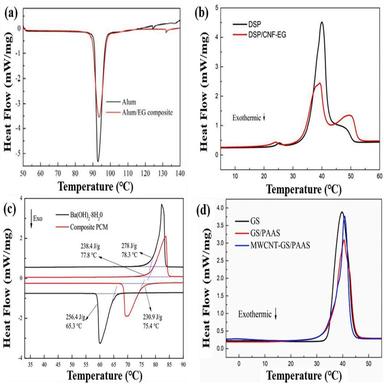
DSC curves of (a) Alum and Alum/EG composite, Reproduced with the permission of Elsevier. (b) DSP and DSP/CNF-EG, Reproduced with the permission of IOP Publishing. (c) Ba(OH)2⋅8H2O and Ba(OH)2⋅8H2O/EG , Reproduced with the permission of Elsevier. as well as (d) GS and GS/PAAS . Reproduced with the permission of Elsevier.